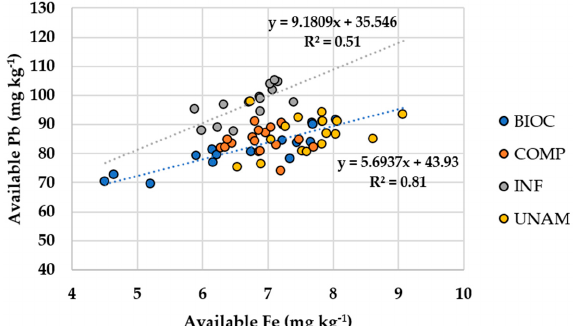
Figure 5. Relationship between soil available iron (Fe) and available lead (Pb) using data from both